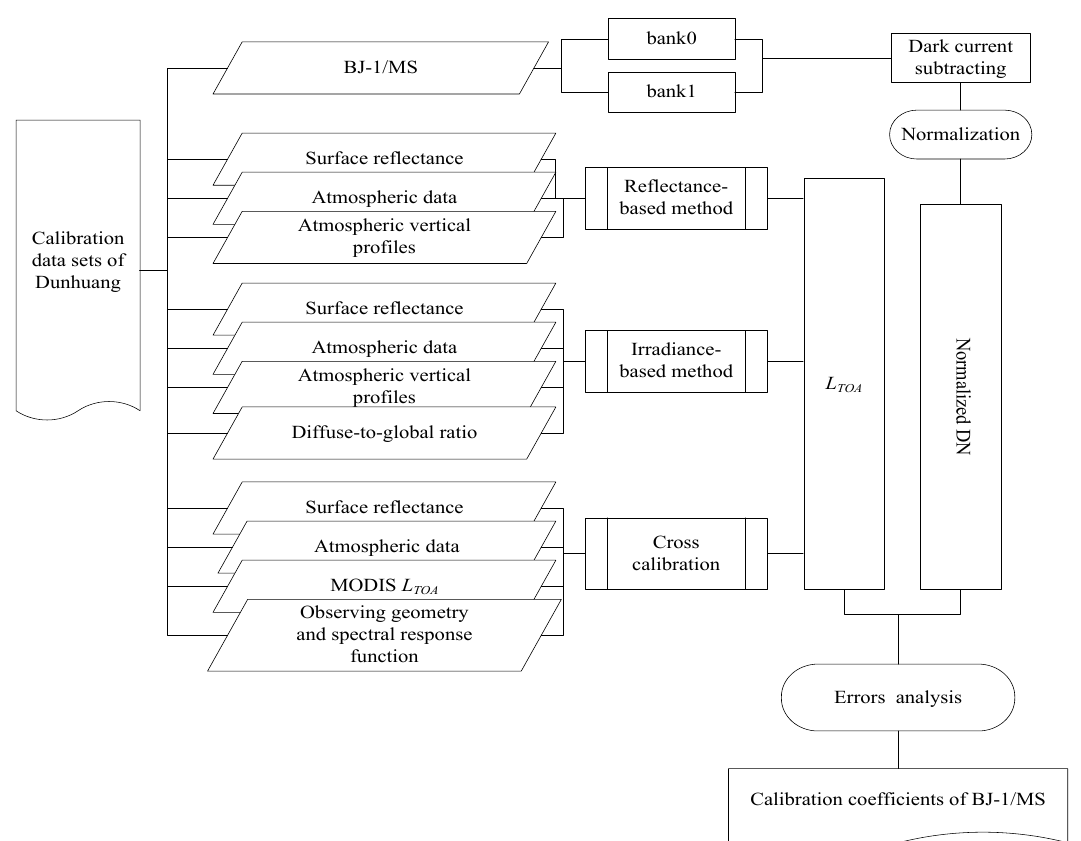
Figure 5. Workflow for vicarious calibration of